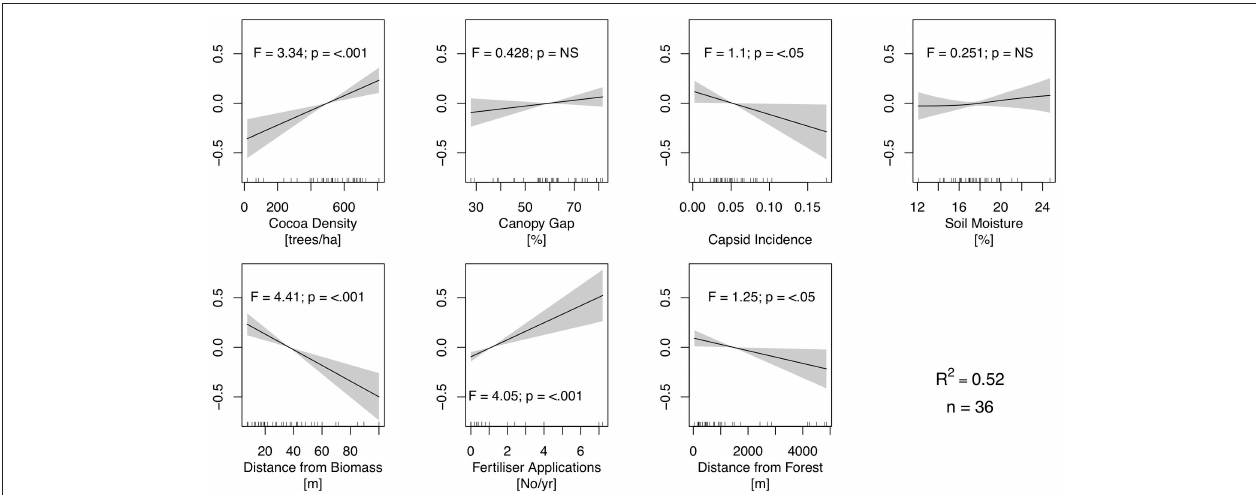
FIGURE 1 | Ecological production function. These are the key factors influencing per tree yields with effect sizes presented over the range of measured values and confidence intervals estimated using a generalized additive model (GAM). Significance of factors are presented by F-values and p-values. The dependent variable is median tree yield calculated from 18 trees for each of 36 farms monitored. R-squared value and sample size are presented.